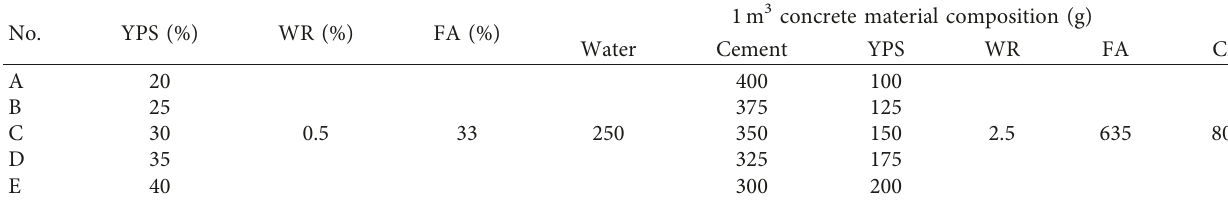
Table 4: Mixture proportions of YPS-CC (by